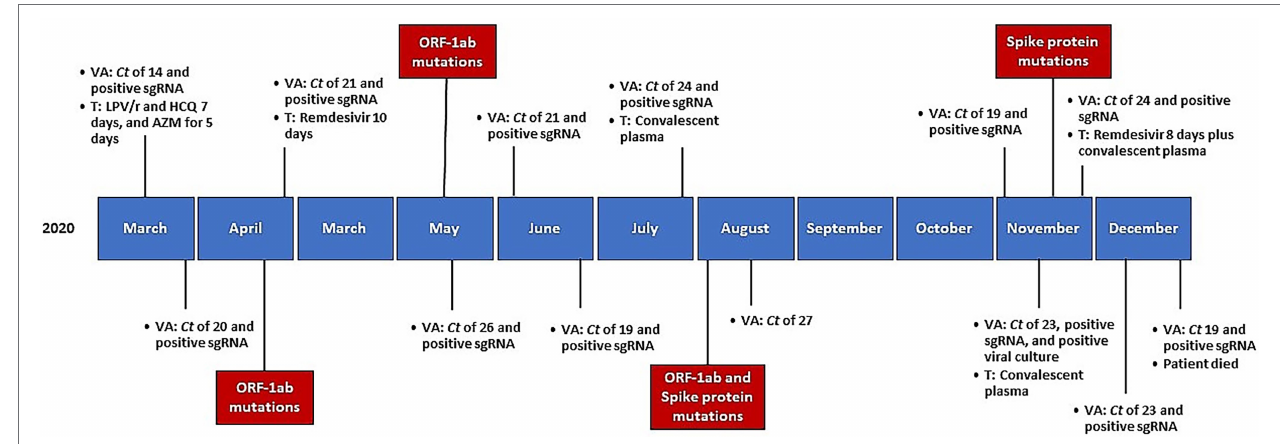
FIGURE 1 | Timeline of microbiological testing, received treatments, and mutations emergence, since initial diagnosis. VA, viral assessment; Ct, cycle threshold; sgRNA, sub-genomic RNA; T, treatment; LPV/r, lopinavir/ritonavir; HCQ, hydroxychloroquine; AZM, azithromycin.